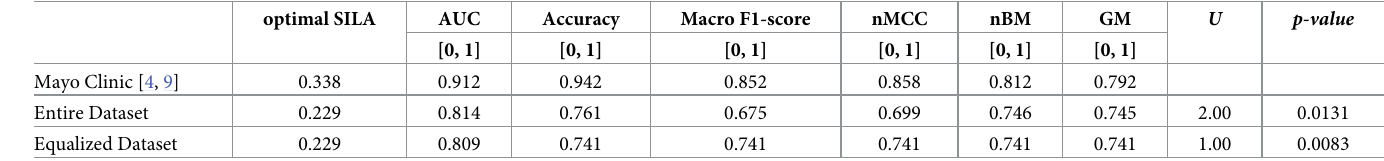
AUC; area under the curve, SILA; score indicative lung cancer aggression, nMCC; normalized Matthews correlation coefficient, nBM; normalized